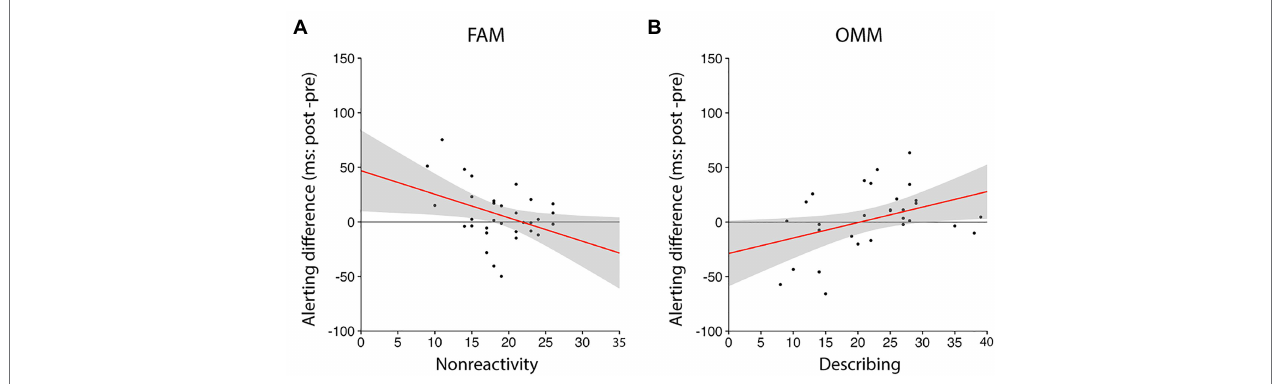
FIGURE 3 | Associations between changes in ANT score and factors in the FFMQ. (A) In the FAM group, the change in the alerting score from pre- to post- meditation was significantly correlated with the nonreactivity score ( r = − 0.38, p = 0.030, see also Table 2 ). (B) In the OMM group, the change in the alerting score from pre- to post-meditation was significantly correlated with the describing score ( r = 0.40, p = 0.030). Black dots and red lines indicate data of individual participants and linear regressed lines, respectively. Grey shaded areas indicate the 95% confidence intervals of the linear regressed